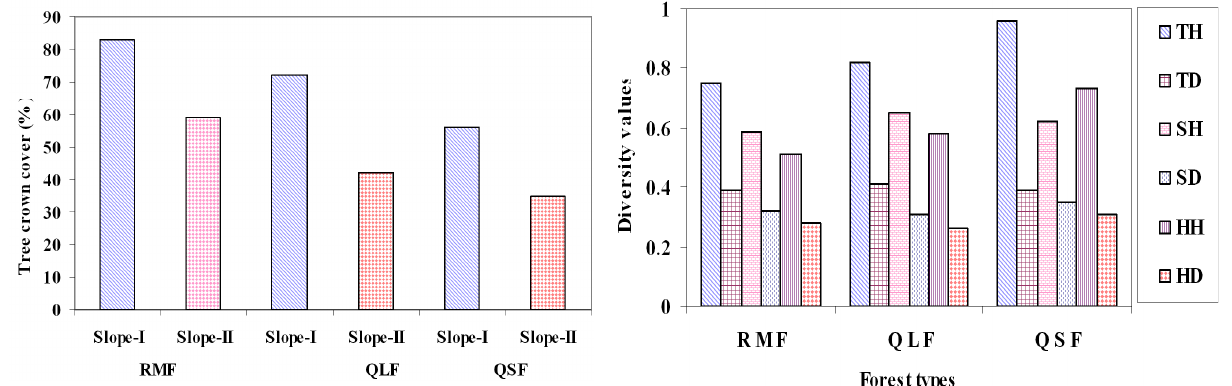
Fig. 2. Relationship between three forest types and diversity in different forests layers; TH=tree diversity; TD=tree domi- nance; SH=shrub diversity; SD=shrub dominance; HH=herb diversity; HD=herb dominance